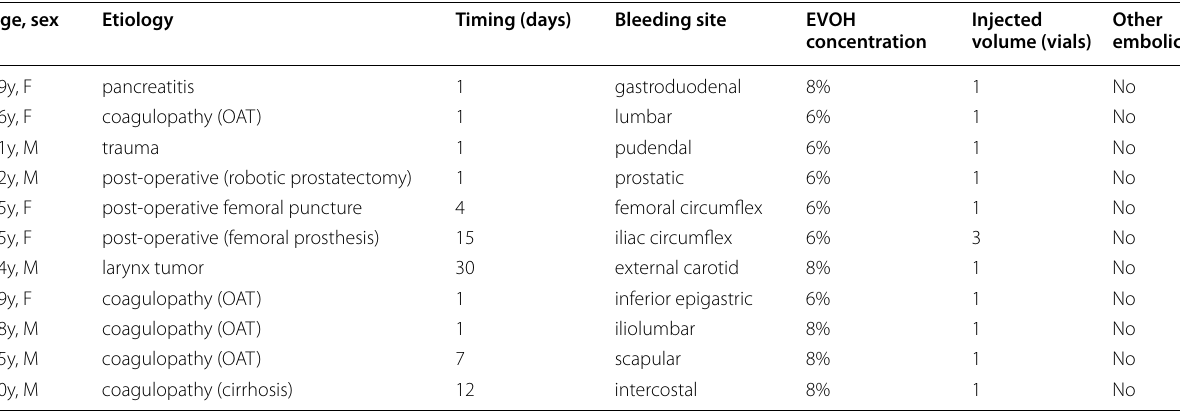
OAT Oral Anticoagulant